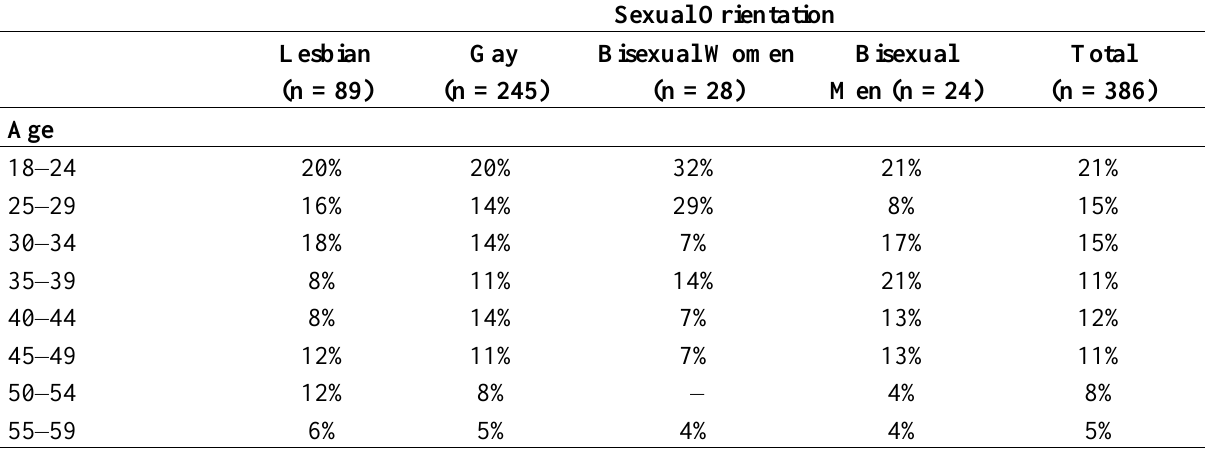
Table 2. Demographic characteristics of survey sample by sexual